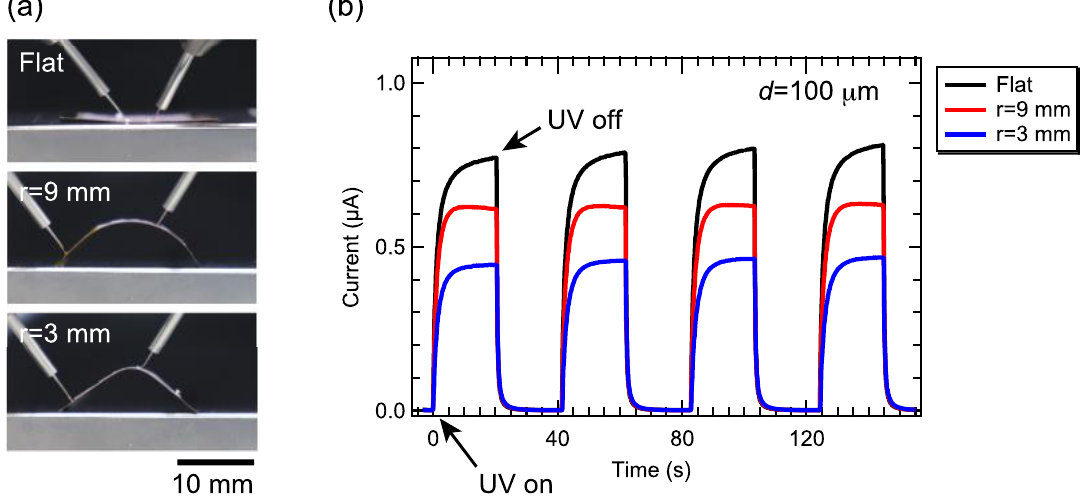
Figure 6. ( a ) Photographs of ZnO–CNF UV sensors in bending states. ( b ) Time evolution of UV light-induced photocurrent for the films with various ZnO contents at the applied voltage of 1.2 V.